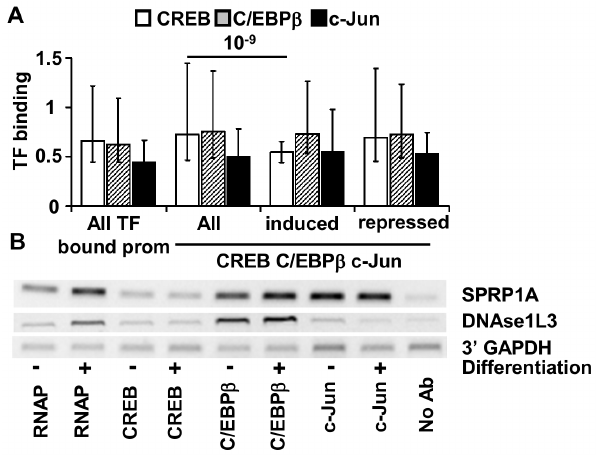
Figure 2. Colocalization of C/EBP b or c-Jun with CREB determine genes which expression and induction upon differentiation is dependent on C/EBP b and c-Jun functions. A. Fraction of genes repressed by A-C/EBP (left panel) or A-Fos (right panel) in differentiated keratinocytes in groups of promoters bound by different combinations of transcription factors. B. Fraction of genes induced by differentiation and repressed by A-C/EBP (left panel) or A- Fos (right panel) in differentiated keratinocytes in groups of genes induced by differentiation which promoters are bound by different combinations of transcription factors. * - numbers are different from expected (p , 0.05 using a two-tailed unpaired t-test). be lower in promoters bound by CREB C/EBP b and cJun and induced by differentiation. Comparison of transcription factor binding distributions in all promoters and promoters bound by CREB, C/EBP b and cJun in differentiated keratinocytes revealed lower levels of CREB binding in promoters bound by all three of these transcription factors and induced by differentiation (Figure 3A). We arbitrarily selected four genes based on different combinatorial recruitment of transcription factors and induction of RNAP binding upon differentiation and show the ChIP-chip binding patterns for RNAP, CREB, C/EBP b and c-Jun across their promoters (Figure S4). Claudin4, SPRP1A and DNAse1L3 with no or low CREB binding were induced by differentiation. In contrast, Ribosomal protein 19 with high CREB binding was not.